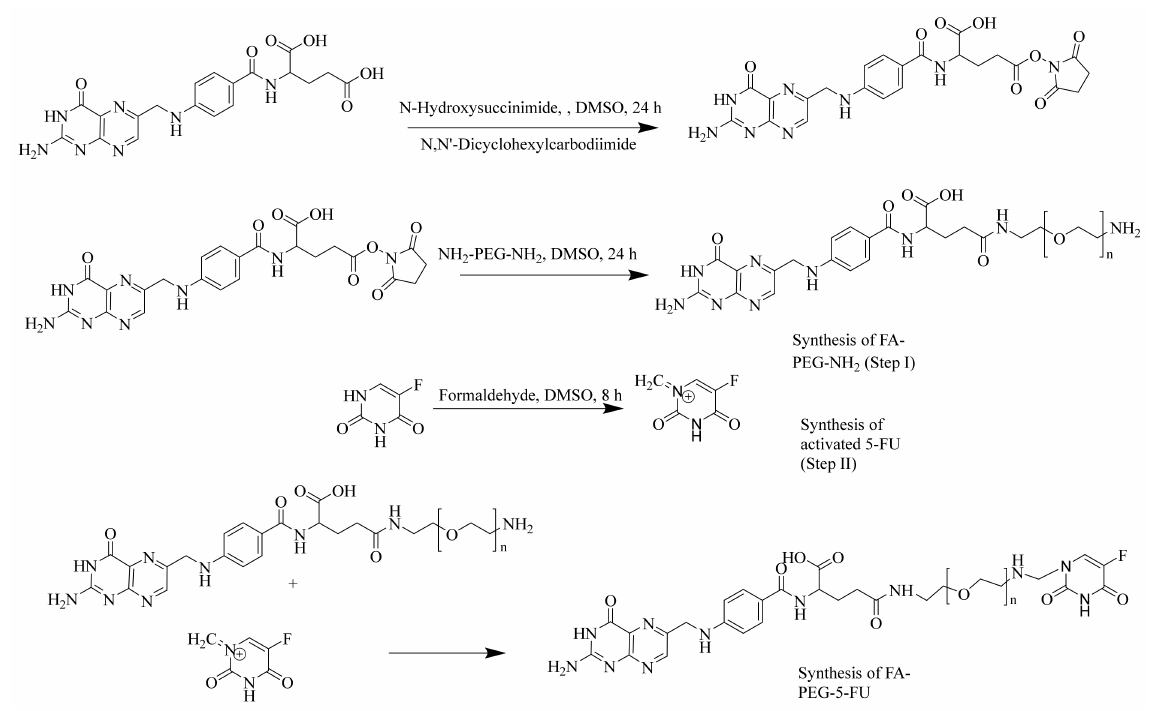
Figure 1. Synthesis of folate-conjugated, polyethylene glycol-loaded 5-fluorouracil. 2.1. In vitro Studies: Drug Release Profile, Cytotoxicity Assay, and Cellular Uptake Efficiency in FR Cells